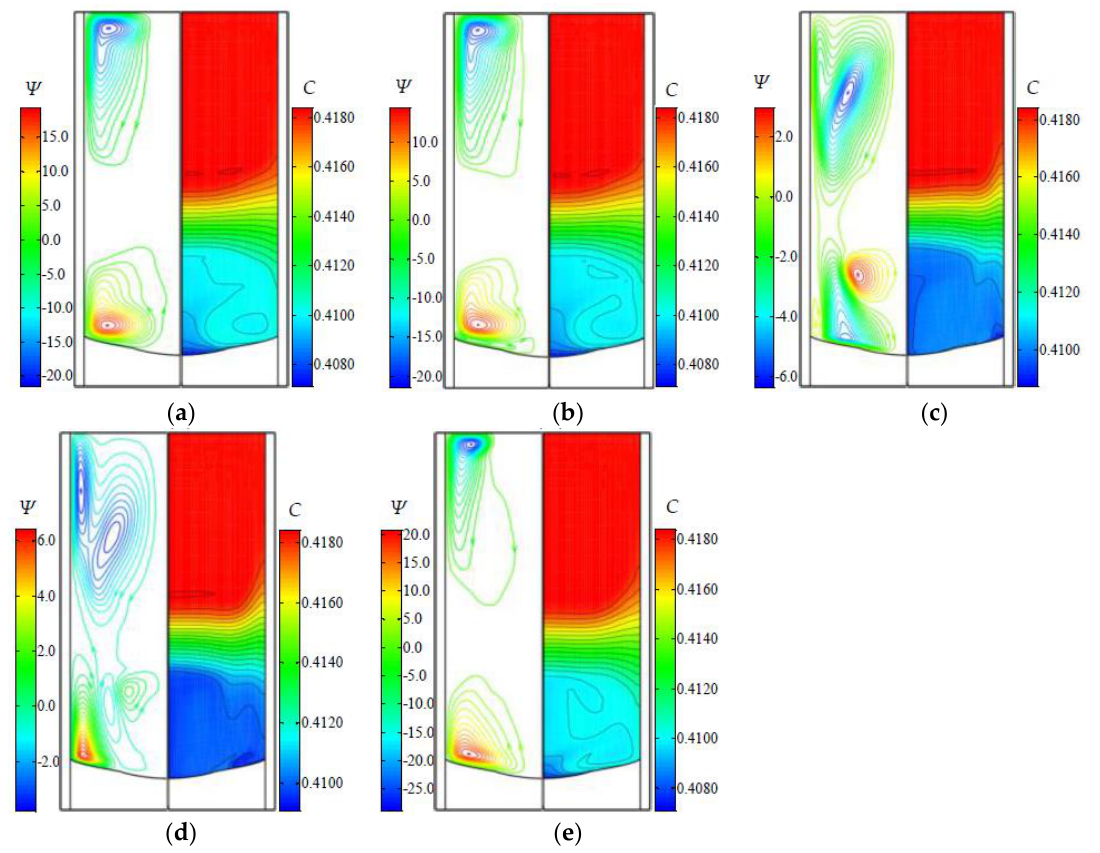
Figure 5. Flow ( Ψ (mm 3 /s)) and concentration ( C ) fields in the solution during the first half of the 5th period of ACRT Sequence 2. ( a – e ) Results at 5A–5E, respectively.